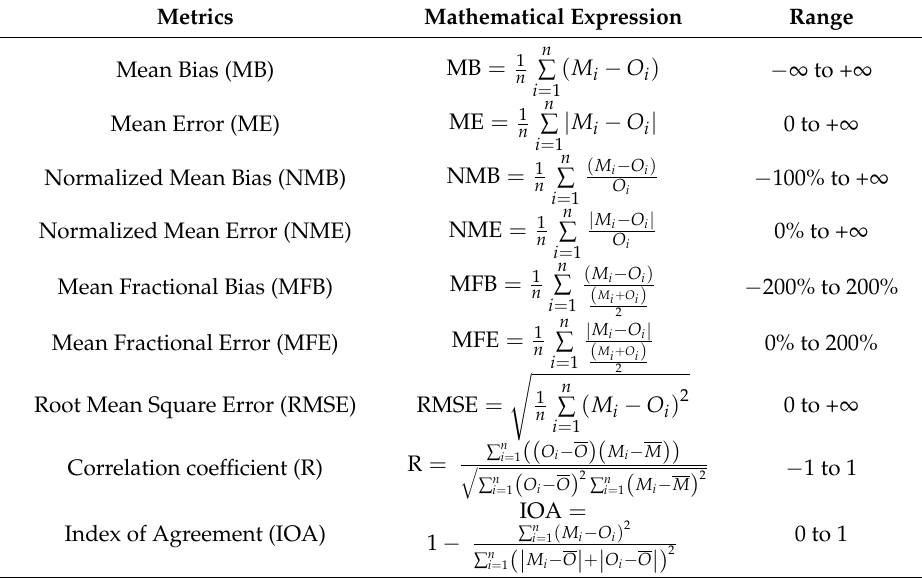
Table A2. Quantitative statistical model performance